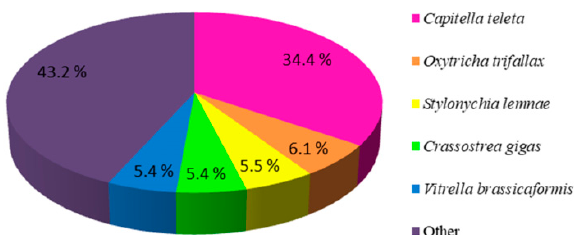
Figure 2. Species distribution of the unigenes from U. unicinctus larval transcriptome with blast in NR database.